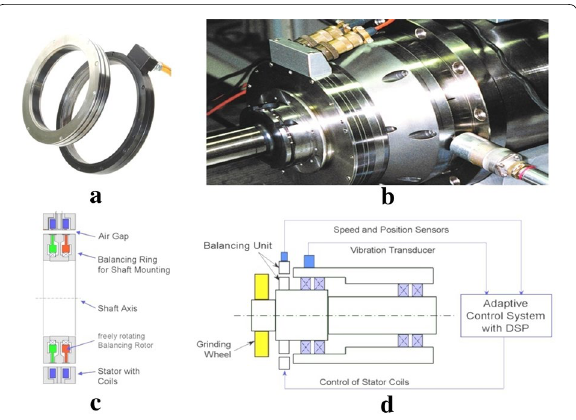
Figure 38 Diagram of electromagnetic ring actuator